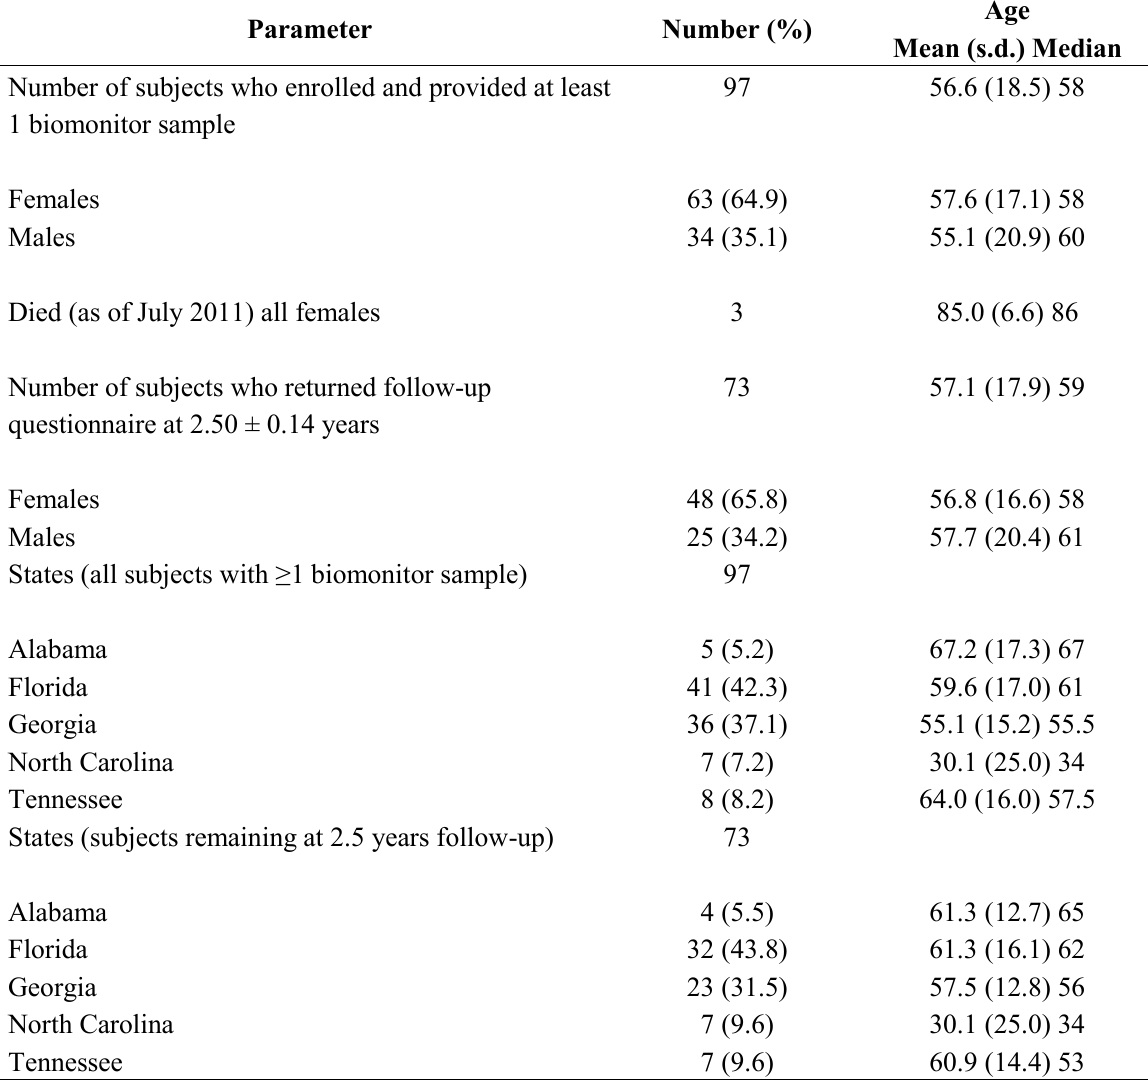
Table 1. Participant age and locale at initial enrollment and at 2.5 ± 0.14 years follow-up.